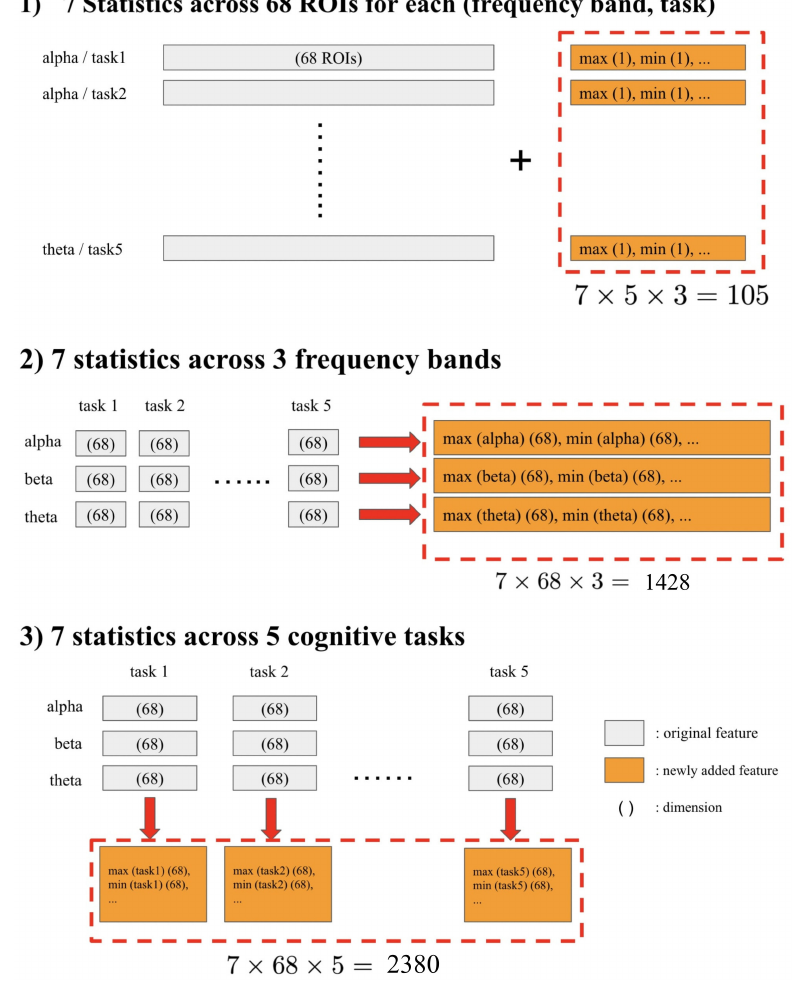
Figure 2. Various statistical measures added as new